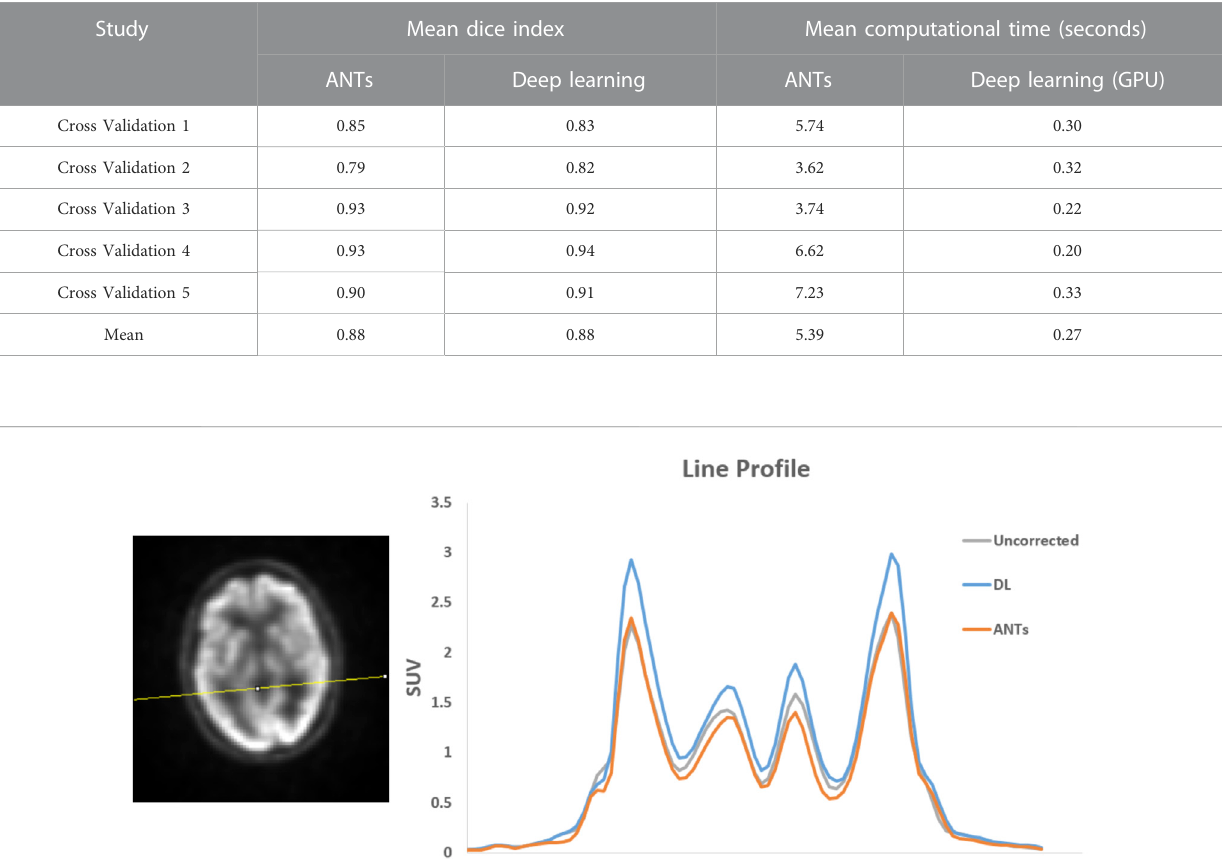
TABLE 2 Comparison of performance in producing motion corrected images.